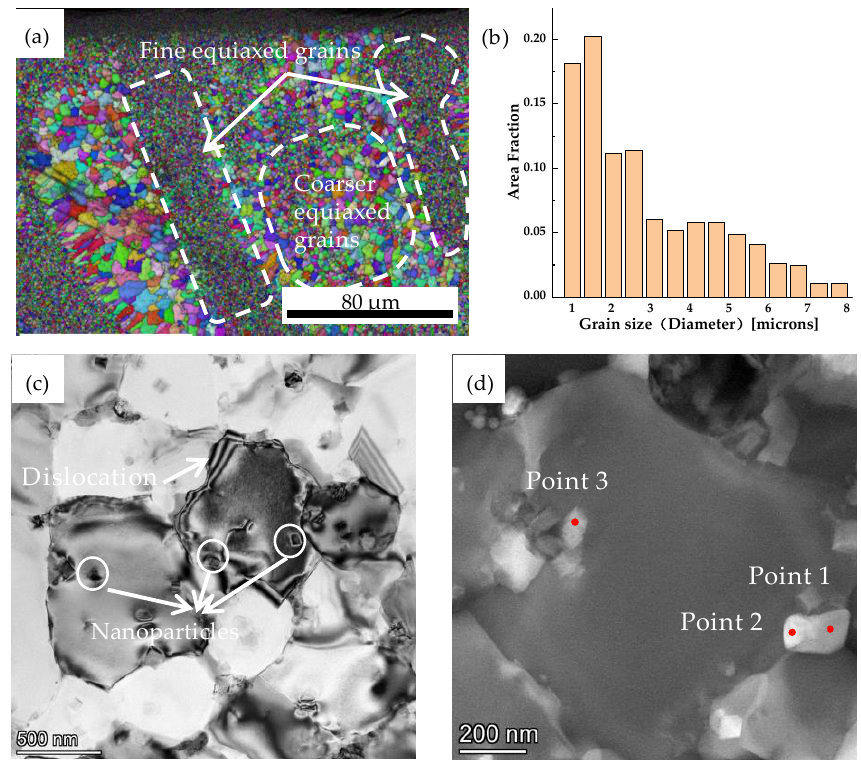
Figure 8. Microscopic analysis of formed sample B3: ( a ) EBSD image. ( b ) Grain Size Statistics. ( c ) Bright-field TEM image, ( d ) Dark-field TEM image.